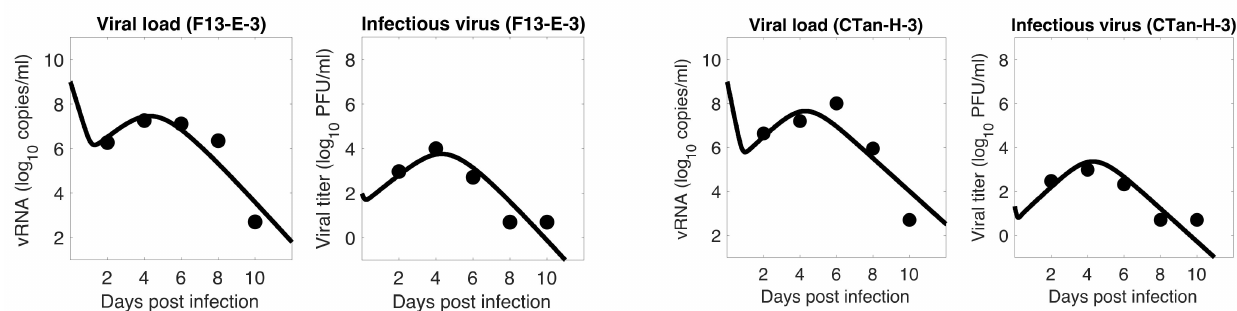
Figure 3. Model 3 fitting to the data. Prediction of the viral dynamics model 3 (solid line) along with the data (filled circle) containing the total viral load (RNA copies per mL) and the infectious virus titer (PFU per mL), collected from ferrets infected with F13-E SARS-CoV-2 and CTan-H